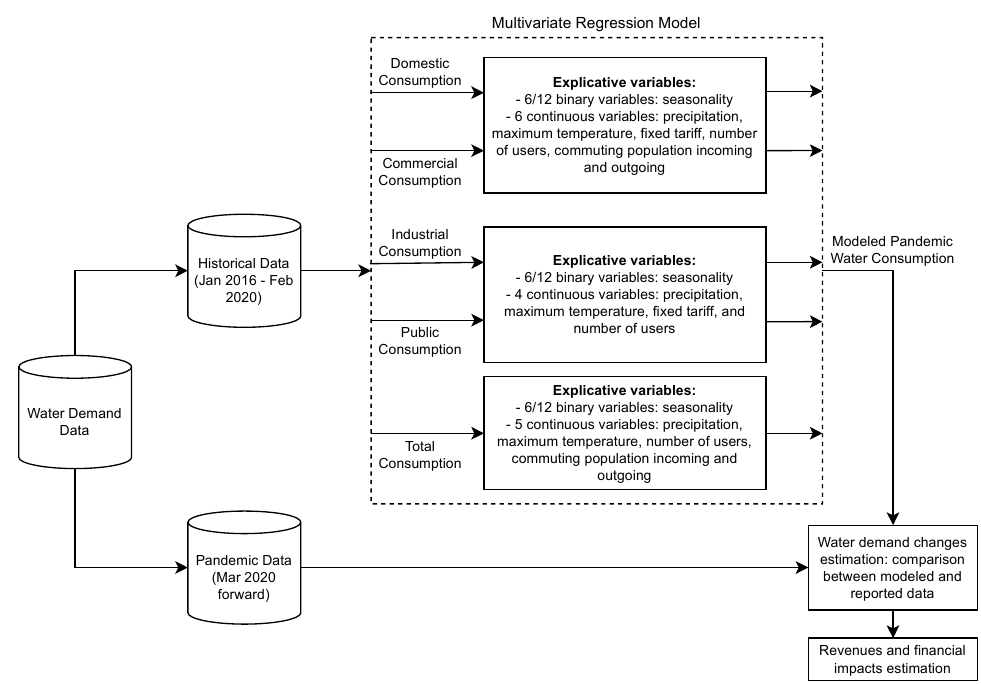
Figure 1. Research methodology scheme.